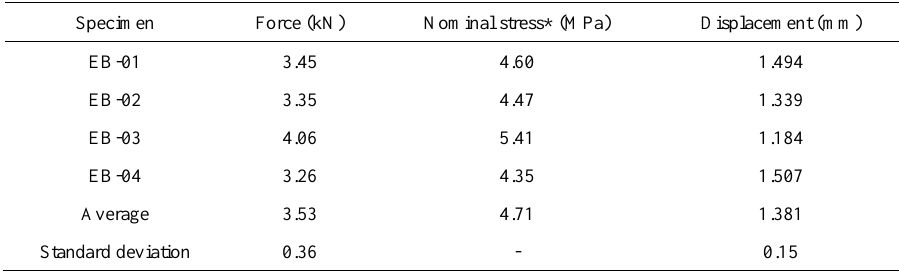
Table 1 Failure test results of TSSA connections on the glass edge